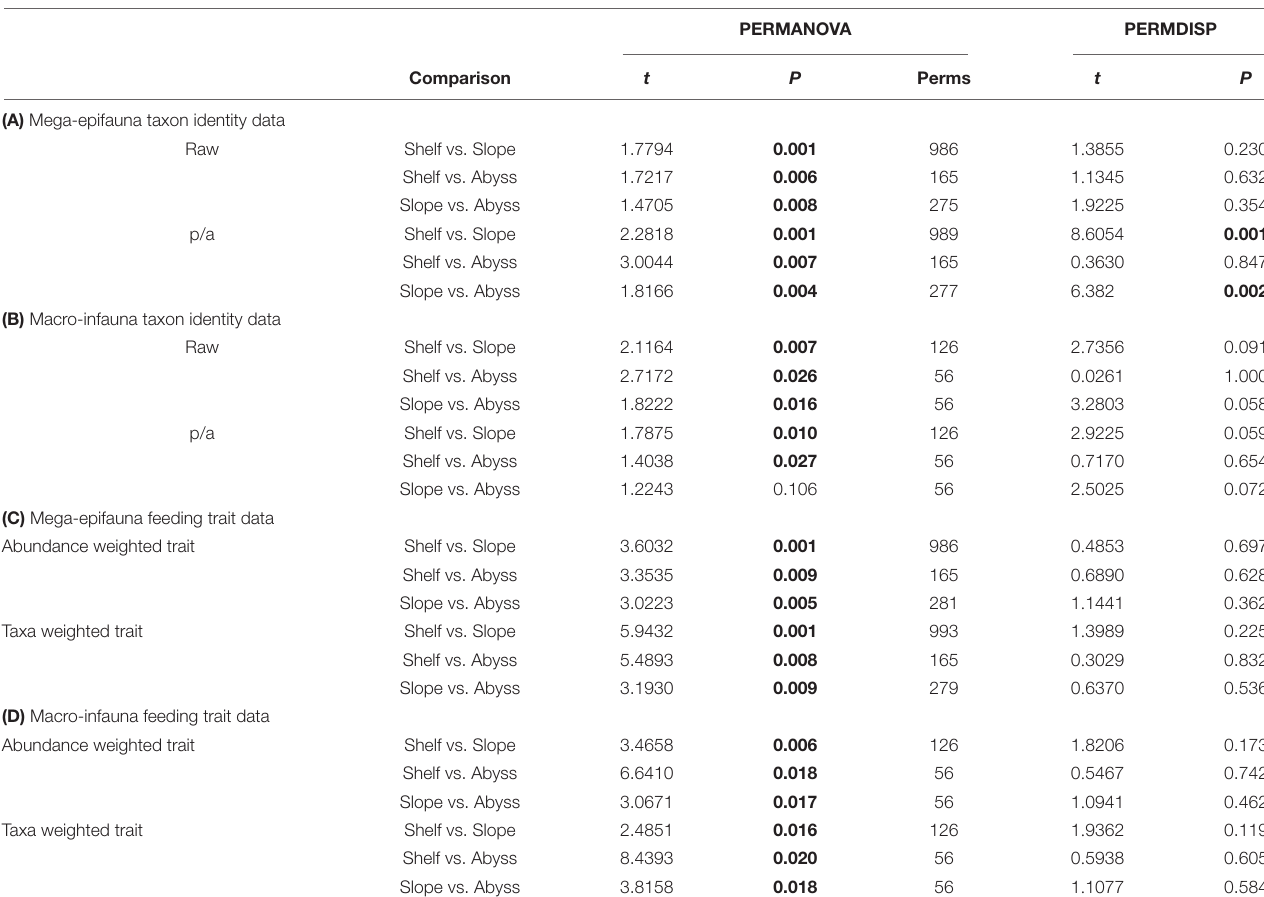
TABLE 3 | Results of pairwise comparisons from PERMANOVA and PERMDISP analyses, testing for differences in benthic community composition between environments, for (A) mega-epifauna taxon identity data, (B) macro-infauna taxon identity data, (C) mega-epifauna feeding traits, and (D) macro-infauna feeding